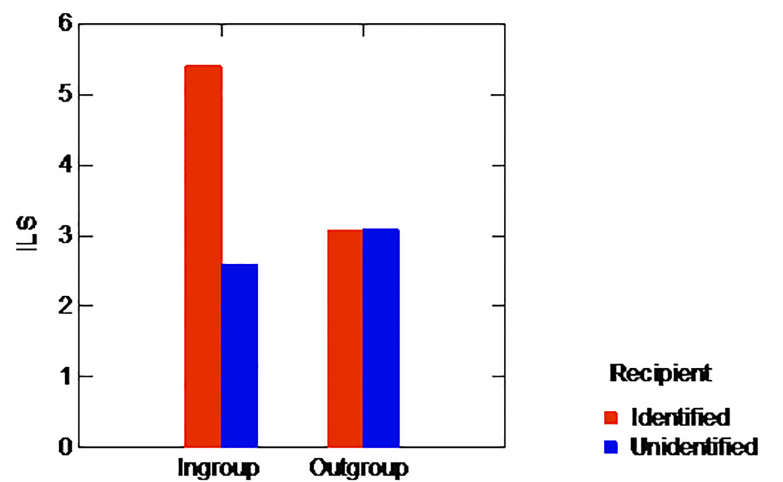
Fig 1. Mean allocation by recipient’s group-affiliation and identifiability, Experiment